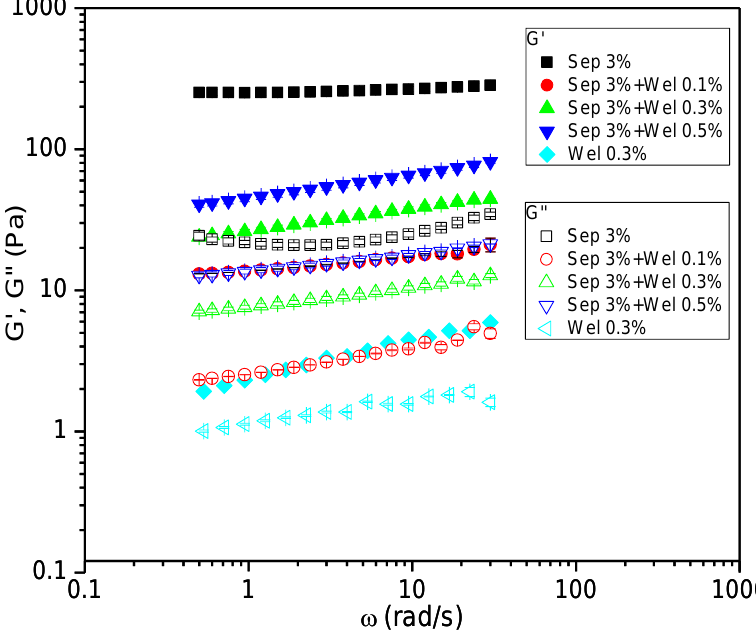
Figure 5. Frequency dependences of G’ and G” modulifor sepiolite gel 3%wt. mixtures with different concentrations of welan gum (aging time = 24 h) at 20 °C. The 0.3%wt. welangum system, for illustrative purposes, was included. The error bars shown correspond to standard deviation.